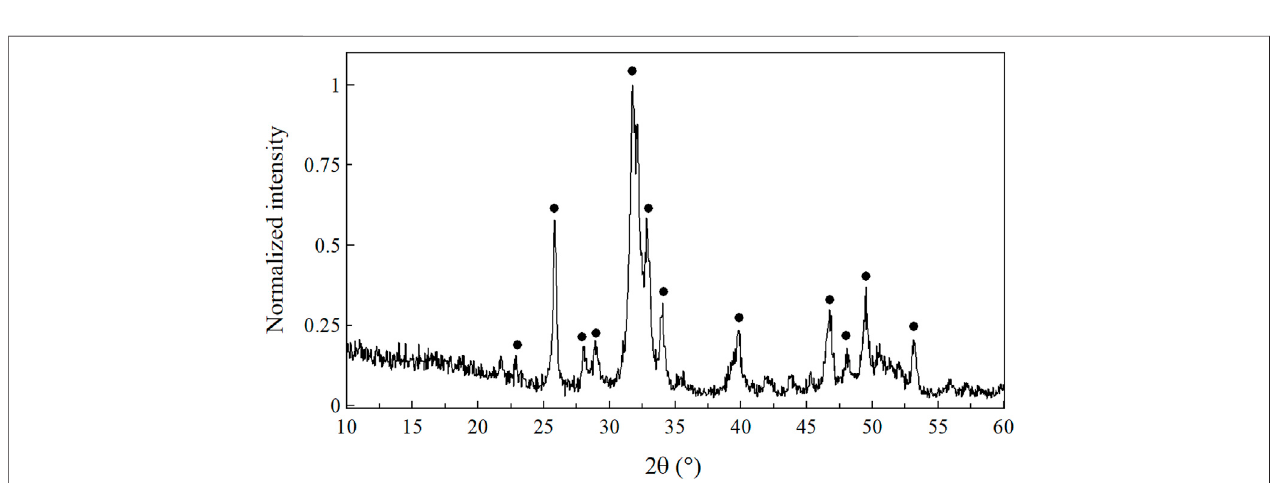
FIGURE 2 | Normalized FTIR-ATR spectra of TCP particles, PDMS-OH macroinitiator, and PDMS- b -PCL copolymer (spectra were shifted from the y -axis in order to show differences).